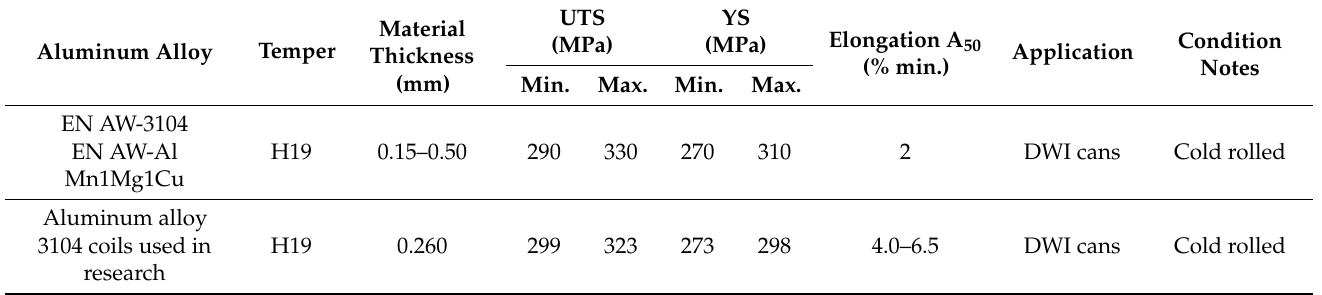
Table 1. Mechanical parameter range for aluminum alloy 3104 and for tested material.